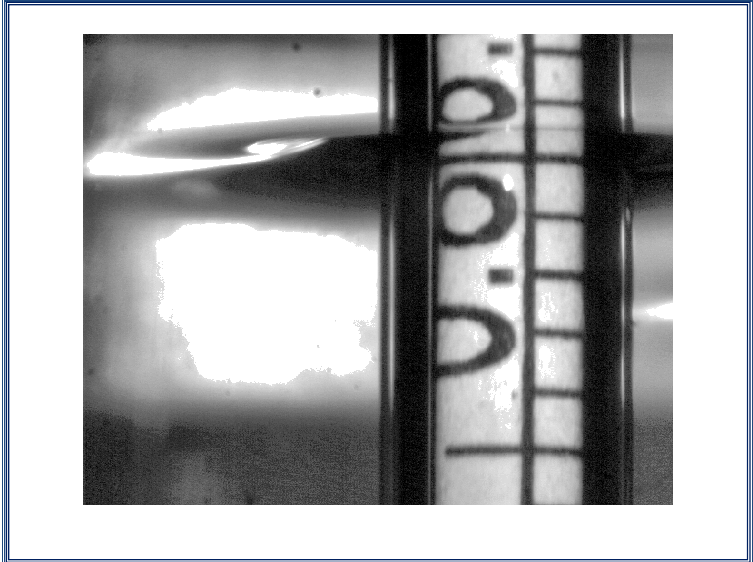
Figure 12. Acquisition and normalization of the image taken with the vision